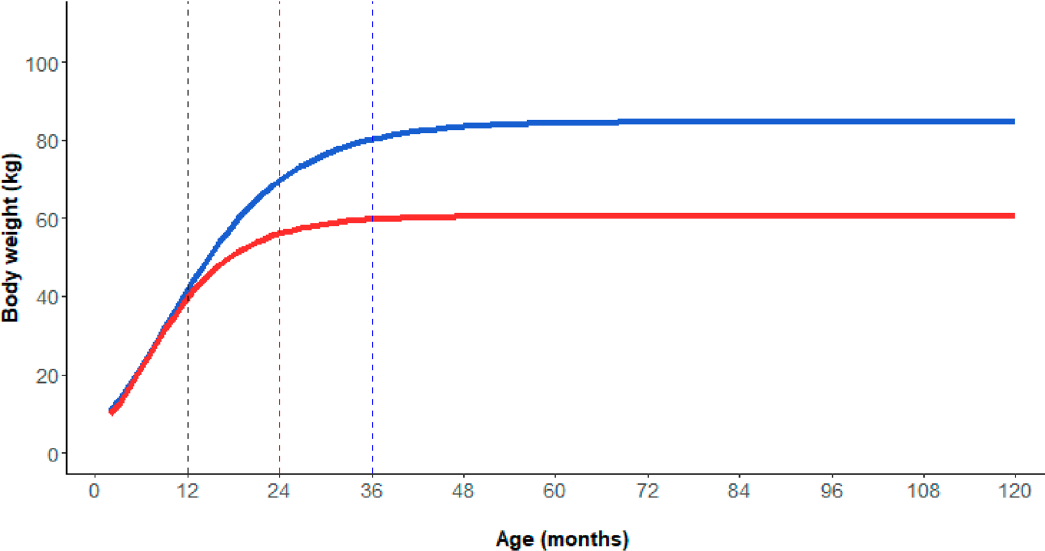
Figure 1. Body weight variation of males (blue line) and females (red line) at growing ages. Values were predicted by the Gompertz growth models separately for males and females (see the text for more details). Vertical dashed lines represent the limits between piglets-subadults (both sexes, black line), subadult-adult females (red line), subadult-adult males (blue line).